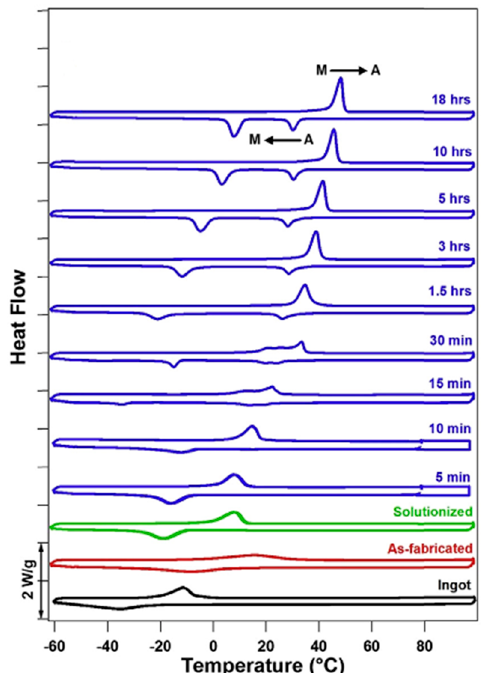
Figure 9. Differential Scanning Calorimetry plot showing the effect of solution annealing and ageing time (blue curves) on Ni(50.8 at.%)Ti Nitinol [78].